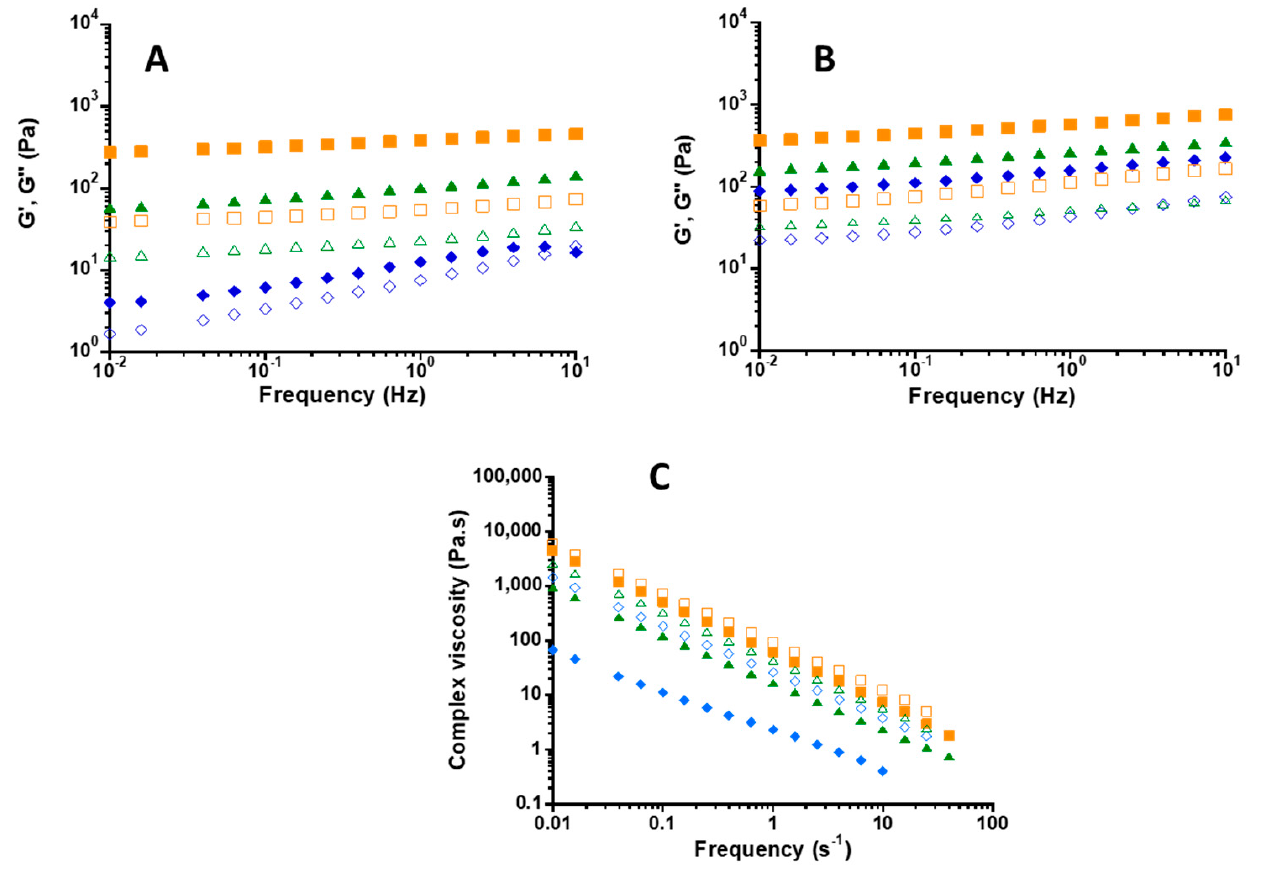
Figure 1. ( A , B ) G’ (full symbols) or G” (empty symbols) (Pa) vs. frequency (Hz) for CNF/XG ratio: 100:0 (blue), 95:5 (green), 60:40 (orange) with final concentrations at 2 wt % ( A ) and at 3 wt % ( B ). ( C ) Complex viscosity (Pa.s) vs. frequency (s − 1 ) for CNF/XG ratio: 100/0 (blue), 95/5 (green), 60/40 (orange) with final concentrations at 2 wt % (full symbols) and 3 wt % (empty symbols), respec- tively.